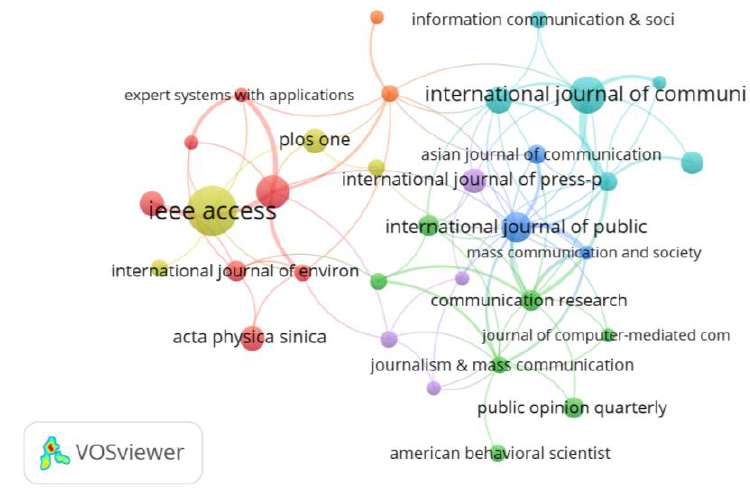
Figure 7. Cooperation of main research journals in NPO studies.